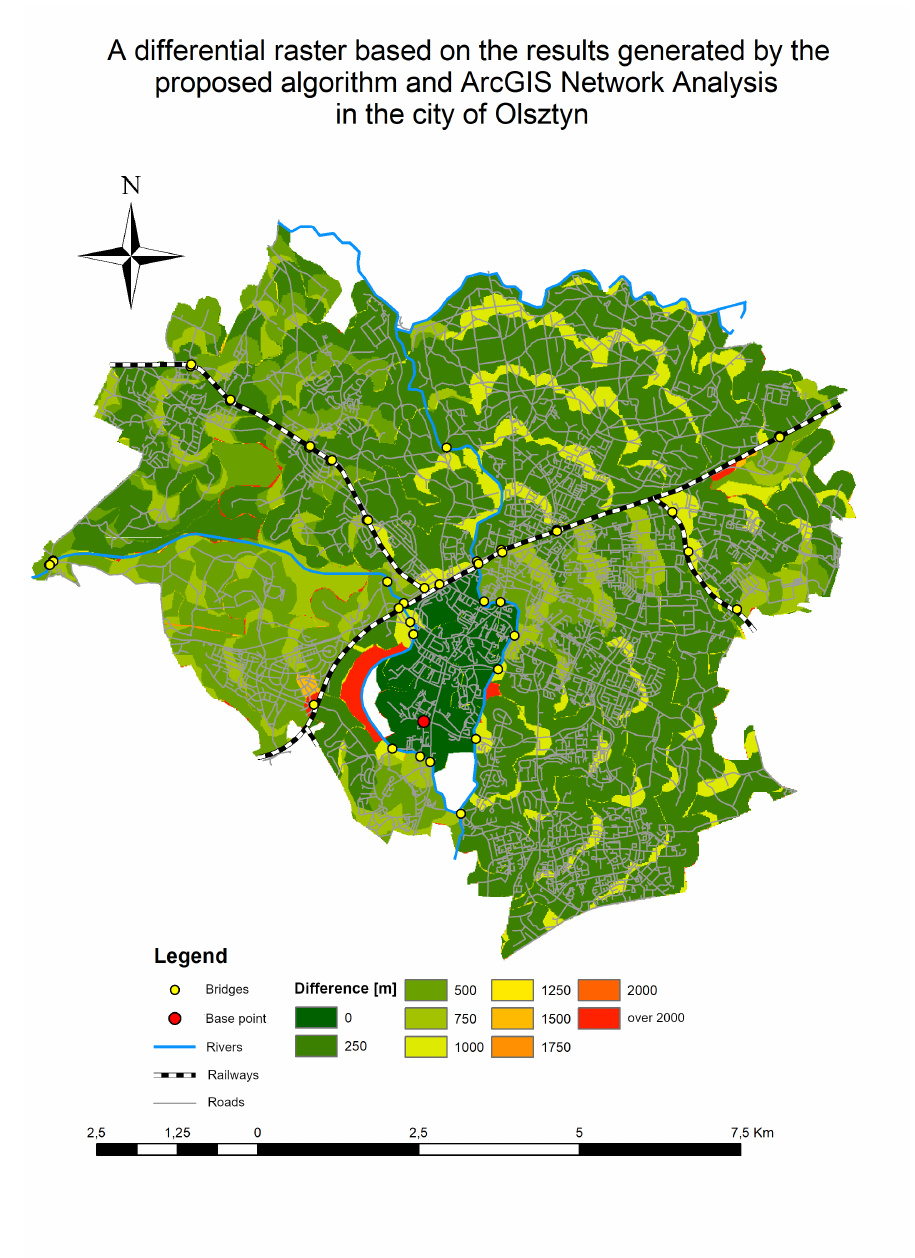
Figure 18. Differences in the generated values of service areas based on Olsztyn data. A differential raster based on the results generated by the proposed algorithm and the ArcGIS tool (Network